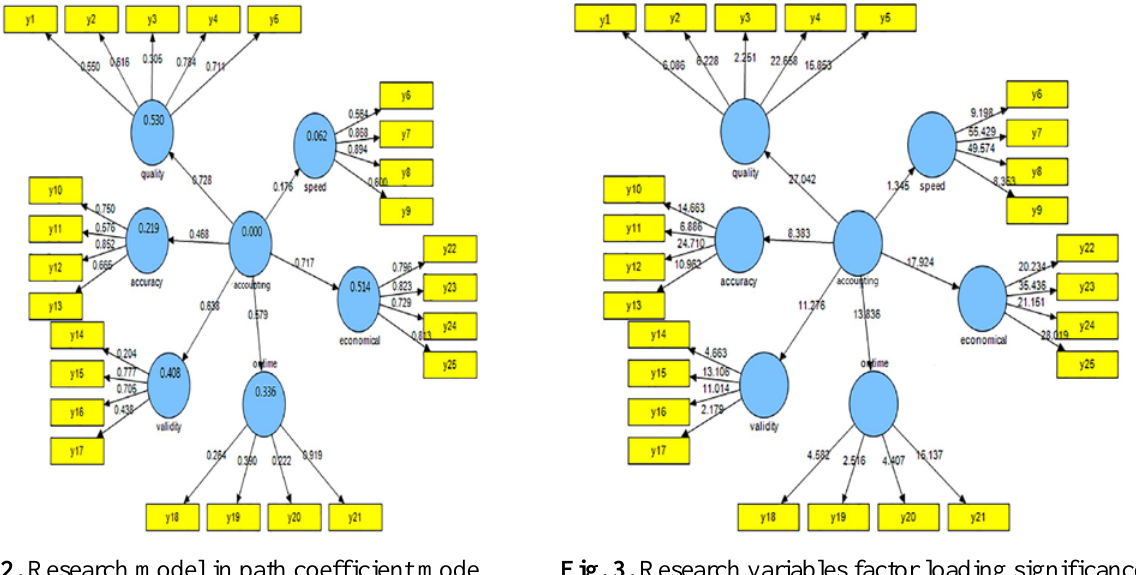
Fig. 2. Research model in path coefficient mode Fig. 3. Research variables factor loading